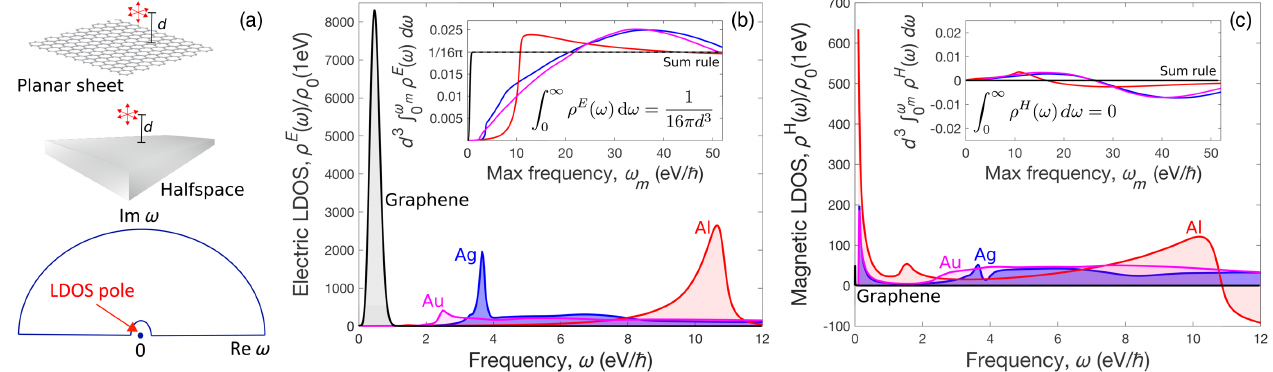
FIG. 2. (a) Contour of integration in the complex- ω plane used to obtain the sum rule for LDOS, which has a simple pole at the origin and is analytic everywhere on the upper half plane. For high-symmetry geometries such as a half-space or planar sheet, the sum-rule constant is known analytically. (b) Electric and (c) magnetic LDOS for Ag, Al, Au (half-spaces), and graphene (planar sheet). Although they all have resonant peaks at different frequencies with varying amplitudes and widths, their integrated response converges to the same constant, 1 = 16 π d 3 , as shown in the inset. The emitter-scatterer distance d is set to 10 nm, and the Fermi level for graphene is set to 0.6